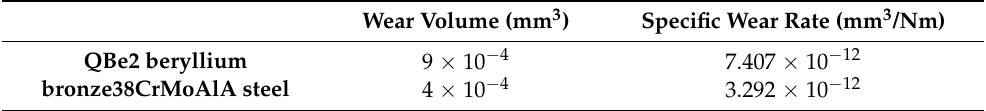
Table 1. Wear volume and specific wear rate of the proposed tribo-pair after 150 h of test.